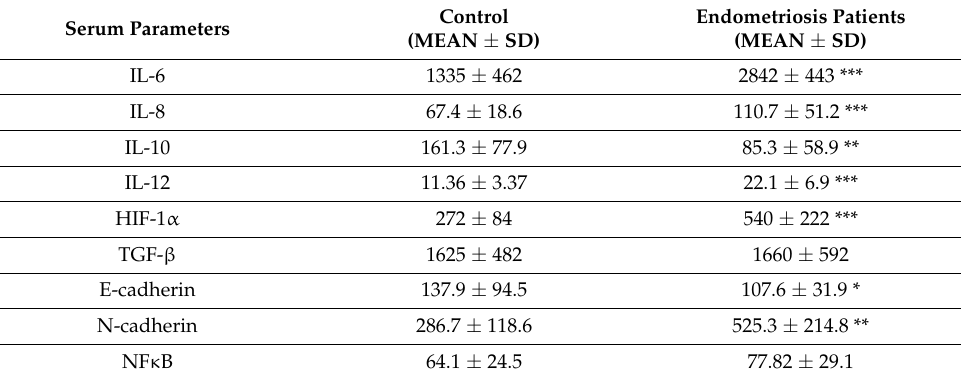
Table 2. Biochemical parameters measured in serum collected at the trigger day from control women and patients with endometriosis. Interleukin (IL) IL-6, IL-8, IL-10, HIF-1 α (Hypoxia-inducible factor 1-alpha), and NF κ B (Nuclear Factor kappa-light-chain-enhancer of activated B cells) are expressed as pg/5 ug total proteins. IL-12, TGF- β (Transforming growth factor beta), E-cadherin, and N-cadherin are expressed as ng/5 ug total proteins. All the data are expressed as mean ± SD. Statistical analysis was performed by unpaired t -test. * p < 0.05, ** p < 0.01, *** p < 0.001 vs. control